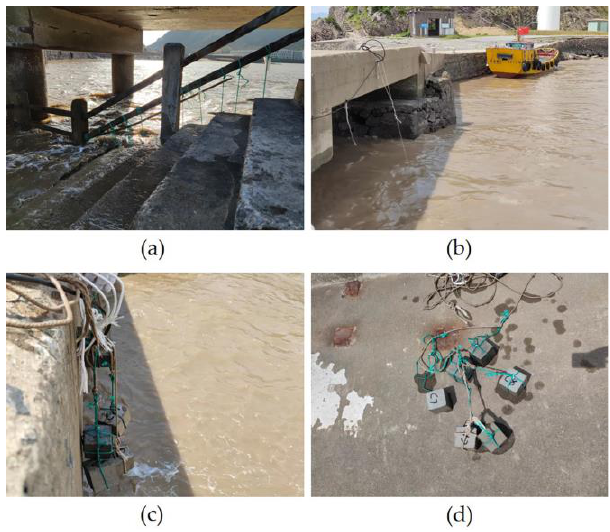
Figure 4. ( a , b ) Test block suspension; ( c , d ) test block